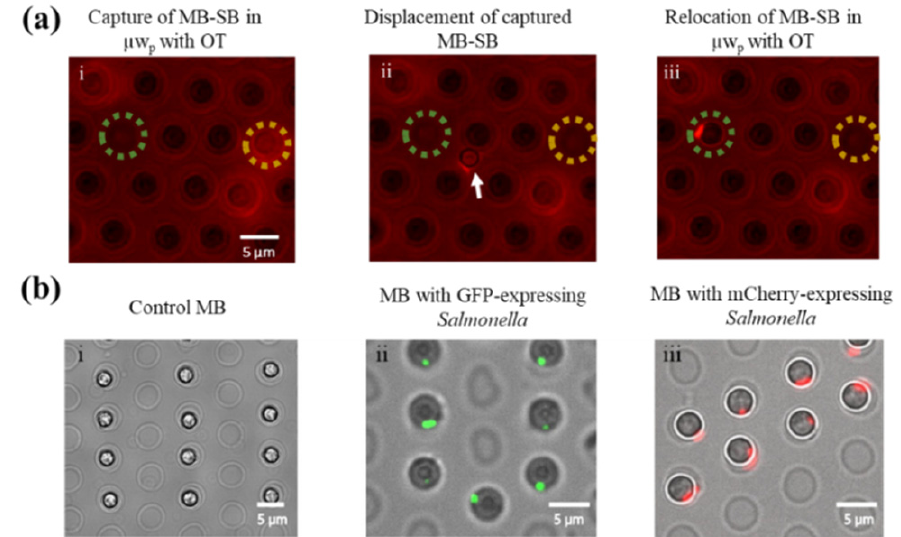
Figure 5. OT-mediated selective retrieval of single bacteria. ( a-i ) MB-SB with mCherry-expression was retrieved from one microwell (yellow circle), ( a-ii ) held in OT-trap, and ( a-iii ) relocated to another microwell (green circle) on the same µw p array, in ~20 s. The OT-held MB-SB during relocation is marked with an arrow in ( a-ii ). ( b-i ) Control MBs, ( b-ii ) MBs with GFP-expressing Salmonella , and ( b- iii ) MBs with mCherry-expressing Salmonella selectively repositioned using OT.